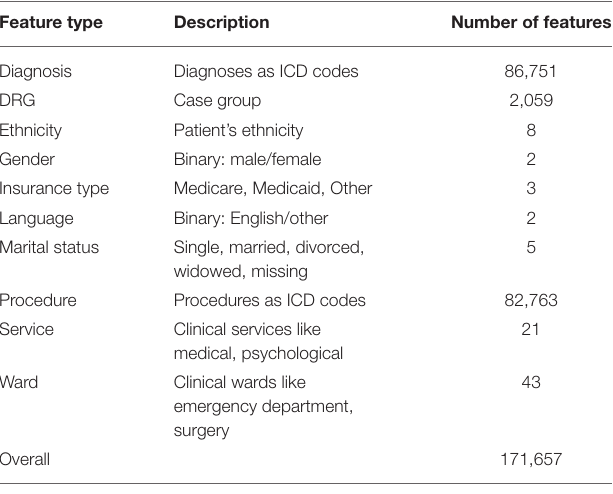
TABLE 1 | A list of all feature types used in this study with a description and the number of features of that type that are available in MIMIC-IV. Feature